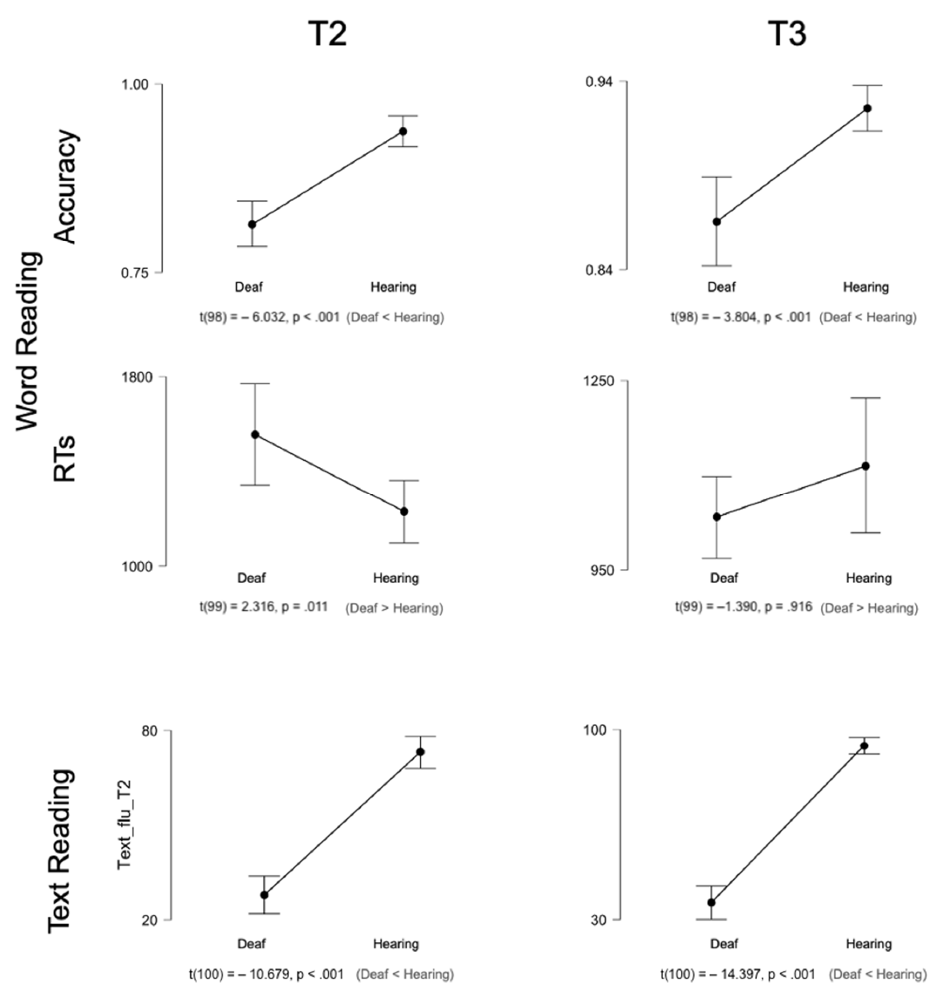
Figure A1. Average word reading accuracy and response times, and average text fluency accuracy at T2 and T3. Error bars represent the confidence intervals (95%). The figure also shows the results from the independent sample t -tests for deaf and hearing participants in all the study measures. Table A1. Behavioural data. Independent samples t -tests between deaf and hearing groups and separated by age group. Significant differences are bolded.